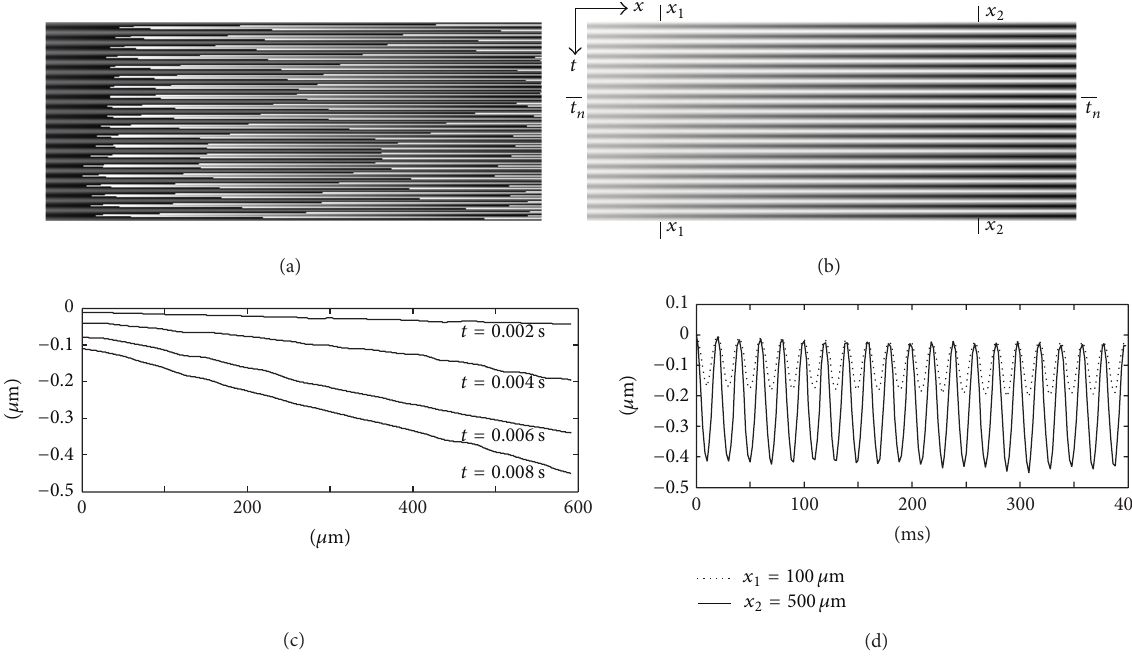
Figure 6: (a) Wrapped phase map in the spatiotemporal plane; (b) unwrapped phase map shows the displacement variation in the spatiotemporal plane; (c) displacement distributions of the cantilever beam at different instants; (d) Displacements of two points on the cantilever beam (reprint from [59]).